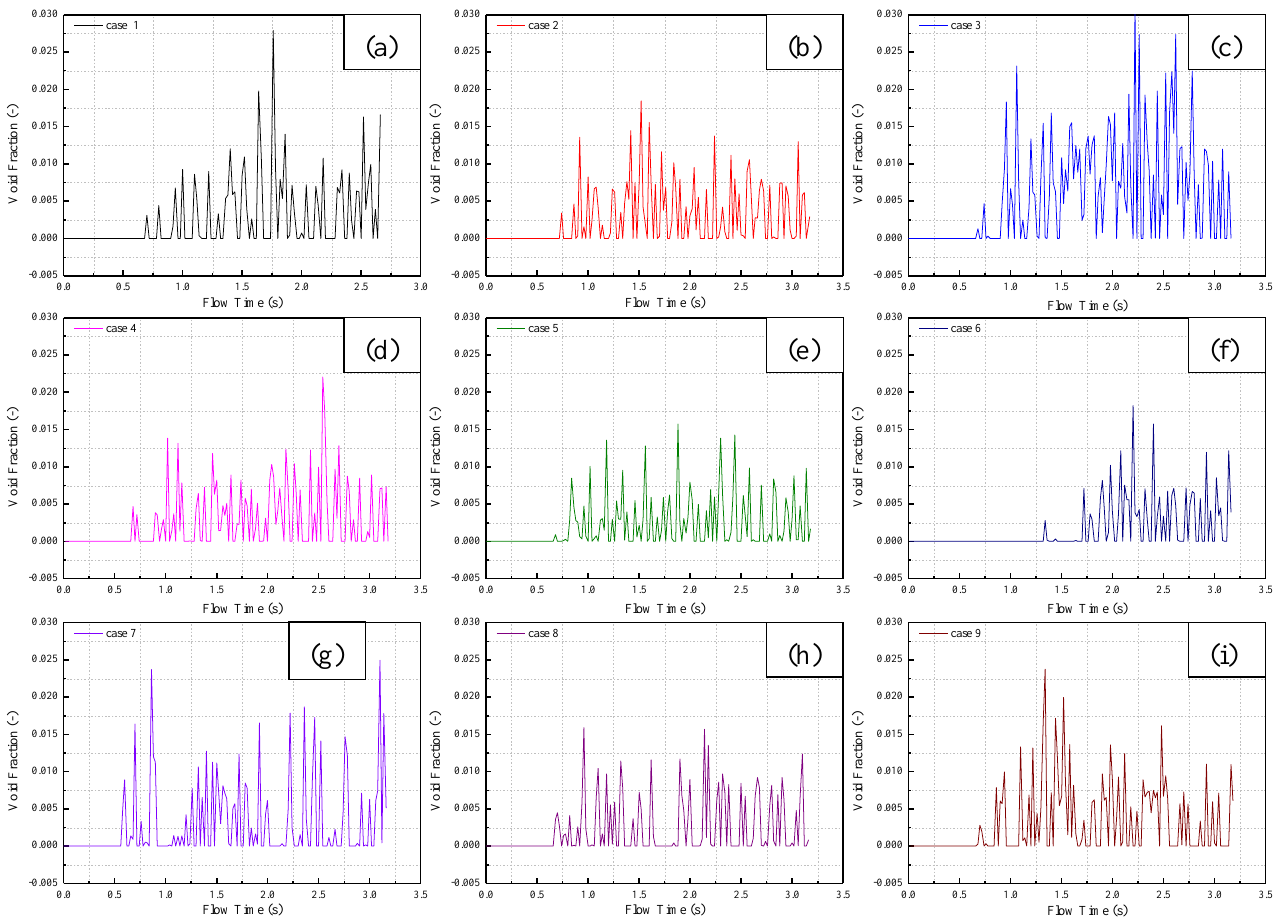
Figure 12. Instantaneous void fraction of outlet surface of Cases 1–9 (seen in Table 1), under different gas–liquid bubbly flow parameters listed in Table 1.